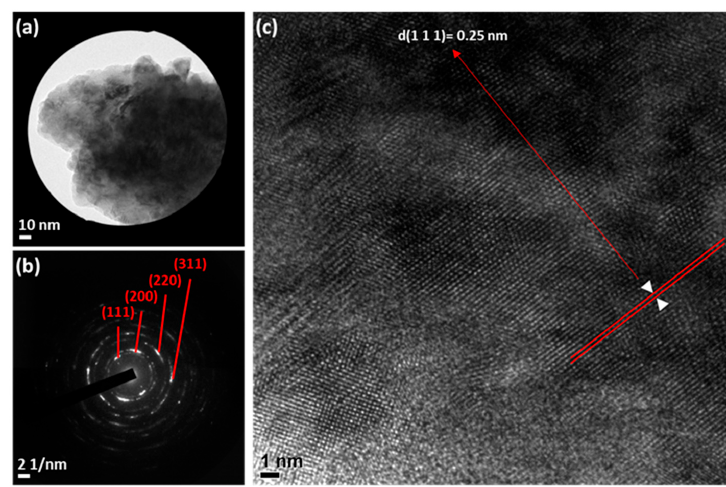
Figure 3. ( a ) Low-magnification TEM image; ( b ) corresponding SAED pattern; ( c ) high-resolution TEM image of the NbC film grown without H 2 on the c -plane sapphire.